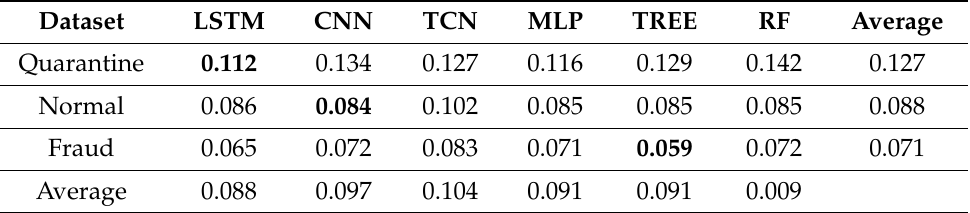
Table 10. WAPE results for each period and each model. The results have been obtained after choosing the best set of parameters for each case by carrying out a parameter optimization process. The last row and column correspond to the means for each model and dataset, respectively. The best model for each dataset is specified in bold.